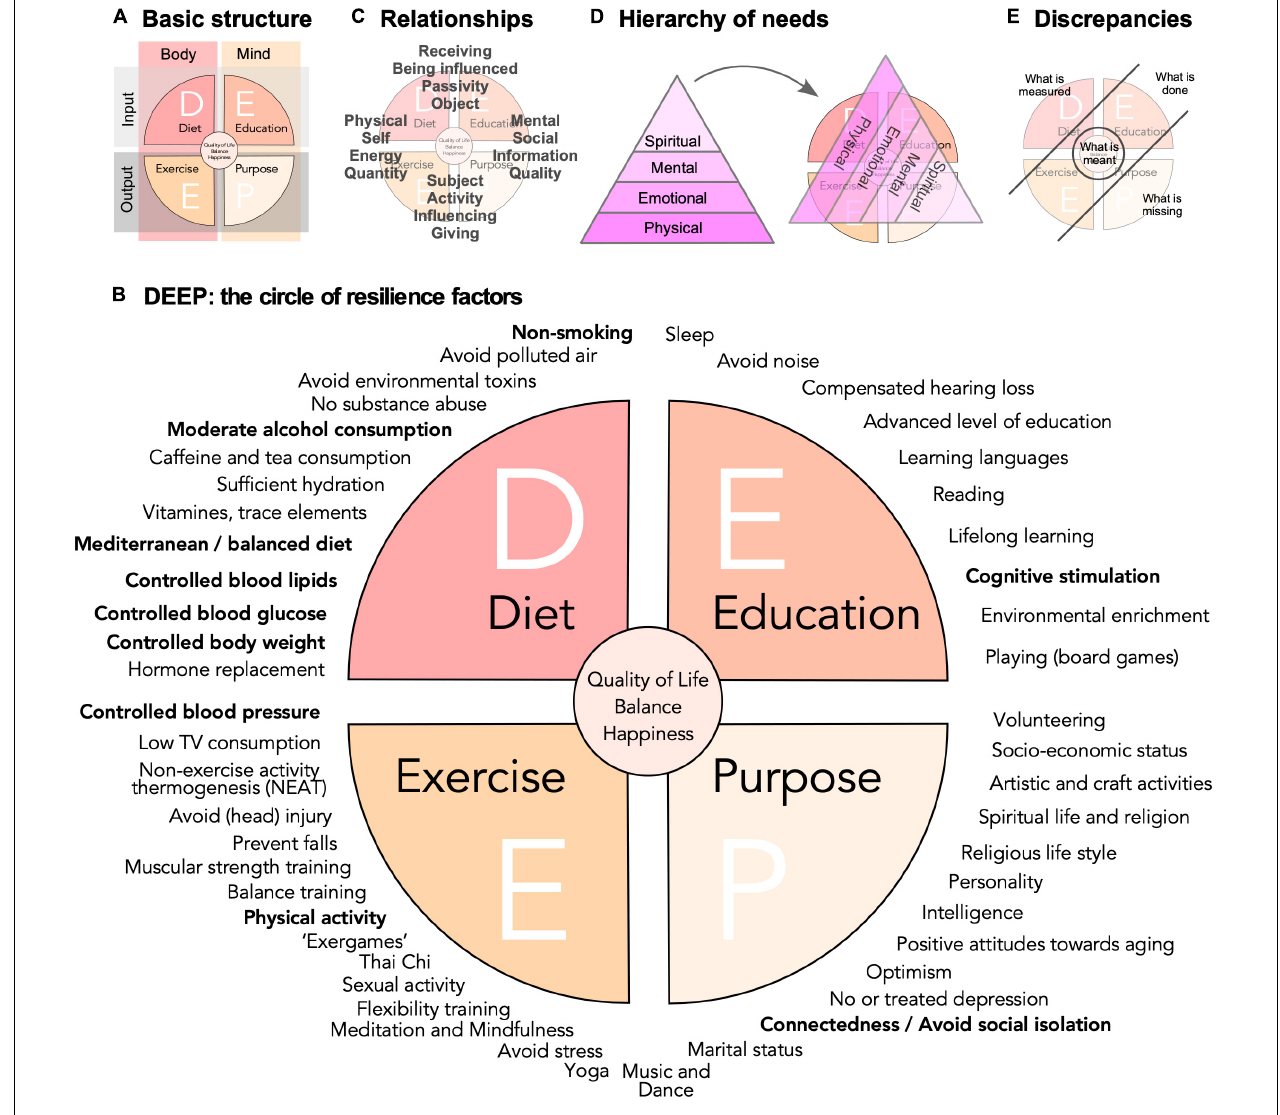
FIGURE 1 | Risk and resilience factors for neurodegenerative disease. (A) The DEEP scheme is based on a four-field matrix, spanned out by body and mind as columns, and input and output as rows. (B) A non-exclusive list of potential lifestyle risk and resilience factors is represented as a circle with the four quadrants obtained in (A) . The WHO factors from the 2019 guidelines are highlighted in bold. They cluster largely in the D quadrant. The WHO in addition states explicitly that vitamin substitution and polyunsaturated fatty acids should not be recommended. Quality of evidence varies greatly, but face validity and popularity might be very high for some factors, for which little data exist. (C) The depiction of the DEEP scheme highlights certain relation pairs and tension fields, which are here meant only as illustration of the complex network of relationships that exist and might influence the impact of lifestyle risk and resilience factors and interventions based on them. (D) As visualized by a hierarchy of needs that drive motivation, here depicted in a version according to Loehr and Schwartz (2005), people will assign different values to different factors and interventions. (E) Further depicts the discrepancy of what is measured (and recommended) and what is done on one side and what is perceived as missing and what is actually meant on the